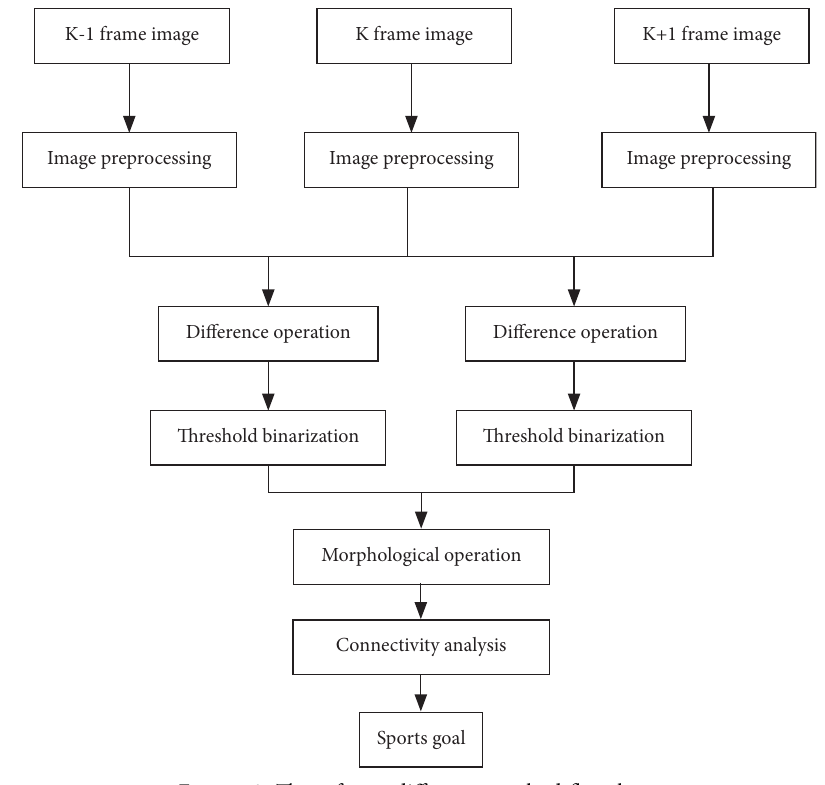
Figure 8: Three-frame difference method flowchart.